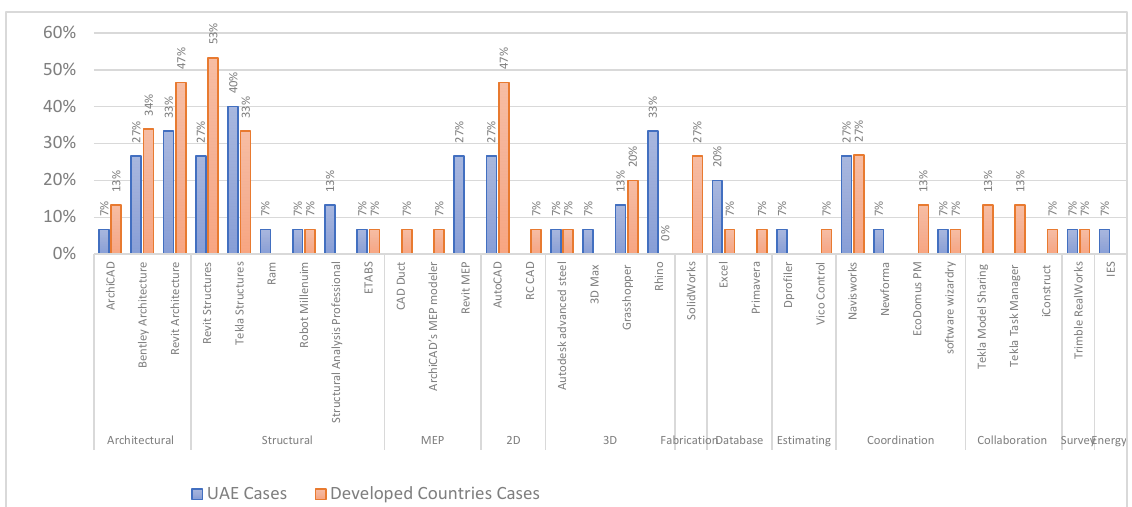
Figure 3. BIM Tools/Software Utilized during BIM Process. Source: [1,15]. (4) BIM benefits